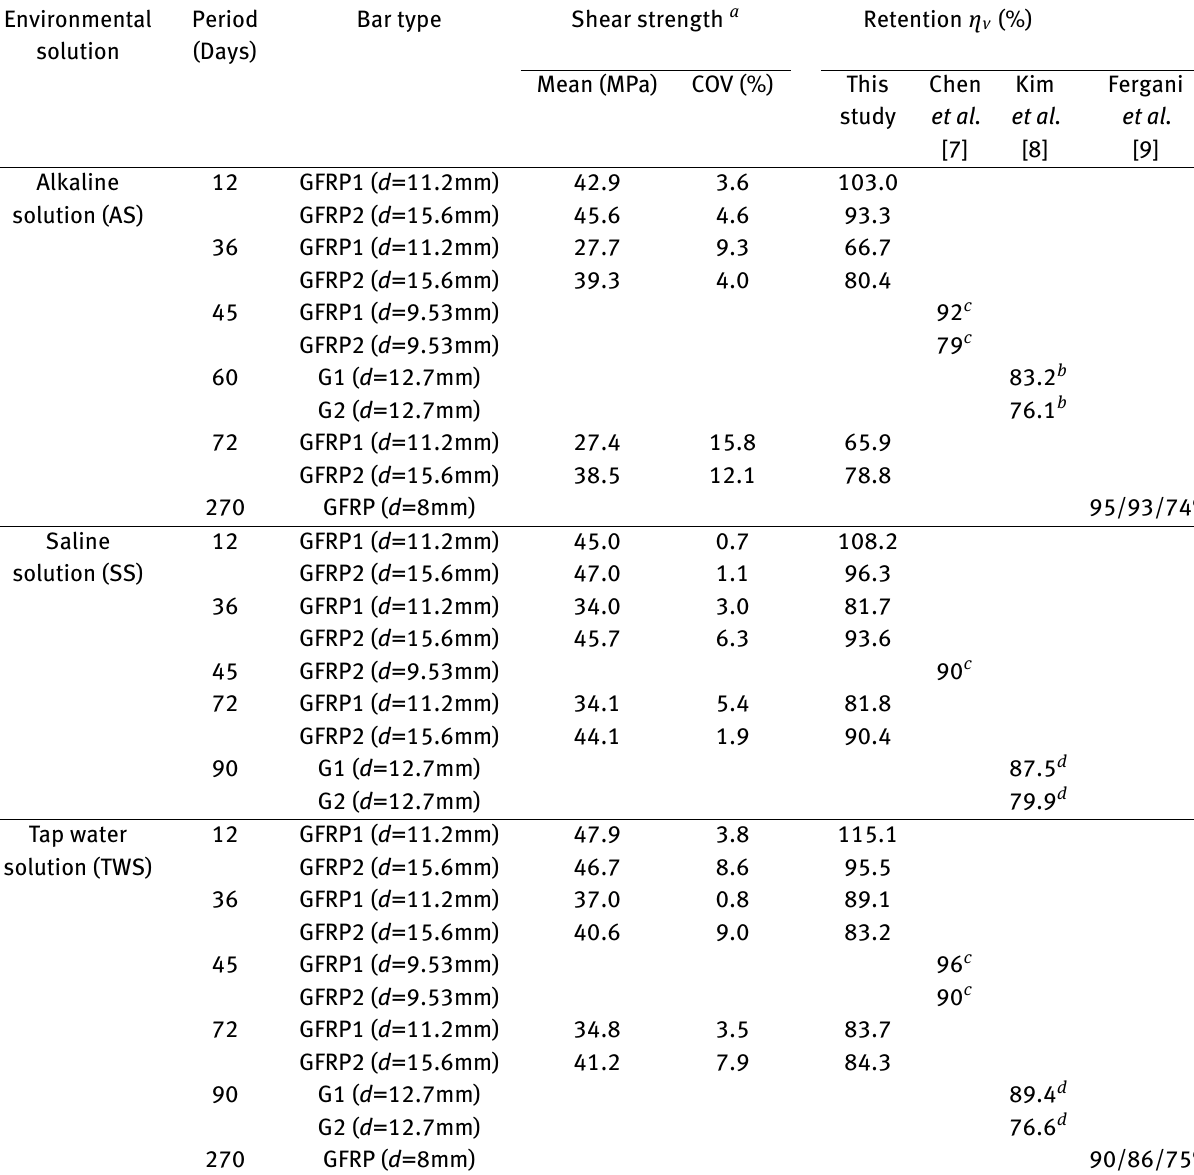
Table 3: Interlaminar shear strength of GFRP bars got from this study and other researches.